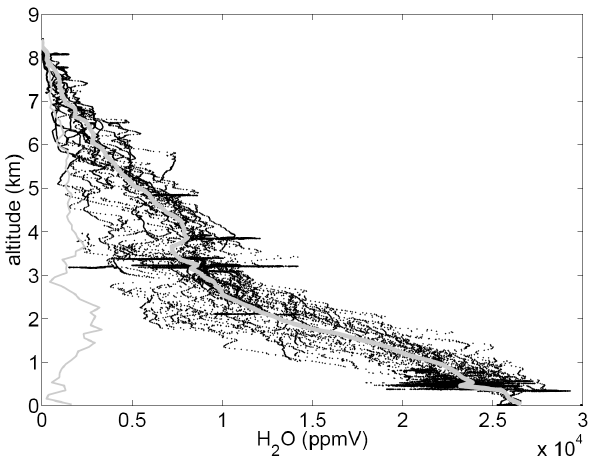
Fig. 4. Observed H 2 O (1s resolution) data for all flights as a function of altitude. The thick grey line denotes the mean values for 100m bins, the thin grey line the standard deviation.